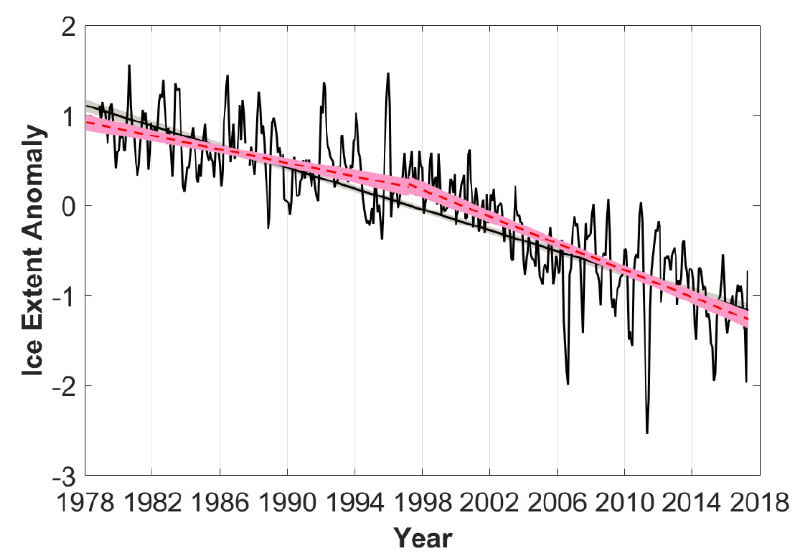
Figure 7. Time series of monthly sea-ice extent anomaly in the Arctic from 1979 to 2017. The gray and red shadings indicate the two-sided 95% confidence boundary.